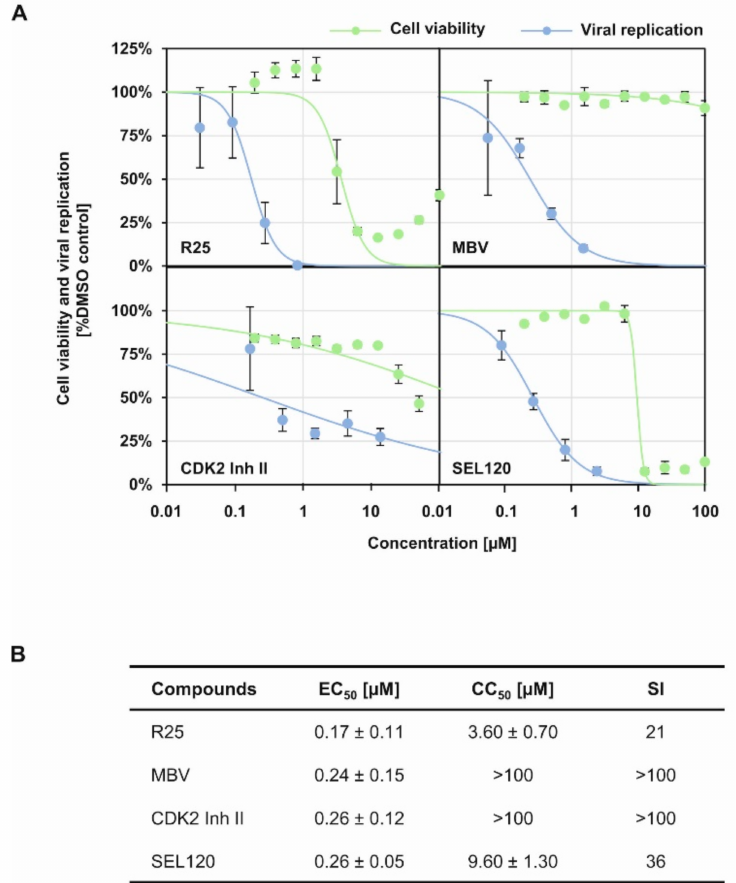
Figure 3. Anti-HCMV activity of CDK/vCDK inhibitors with known relevance for viral NEC regulation. ( A ) Virus yield assay was performed as described in Section 2.8 and anti-HCMV activity of indicated CDK/vCDK inhibitors was assessed (blue curve). In addition, cytotoxicity of the CDK/vCDK inhibitors on HFFs was determined as described in Section 2.10 and CC 50 values were calculated (green curve). ( B ) Determination of values of EC 50 , CC 50 and SI, as based on the data provided by panel ( A ). Mean values ± SD of triplicates are